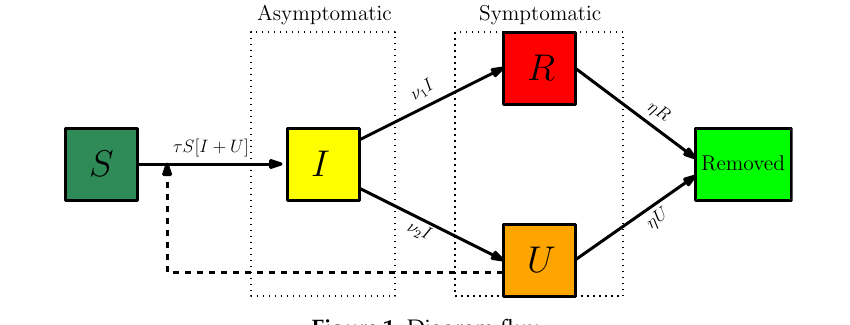
Figure 1. Diagram flux. Table 1. Parameters of the